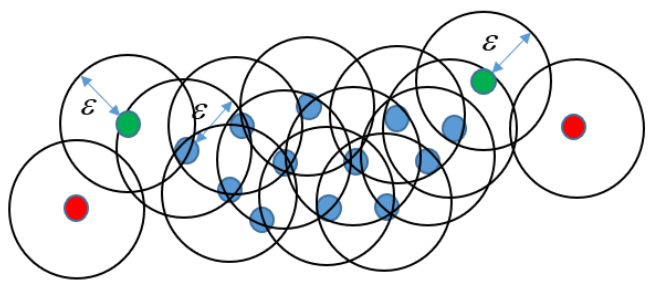
Figure 4. Illustration of density-based spatial clustering of applications with noise (DBSCAN) pro-